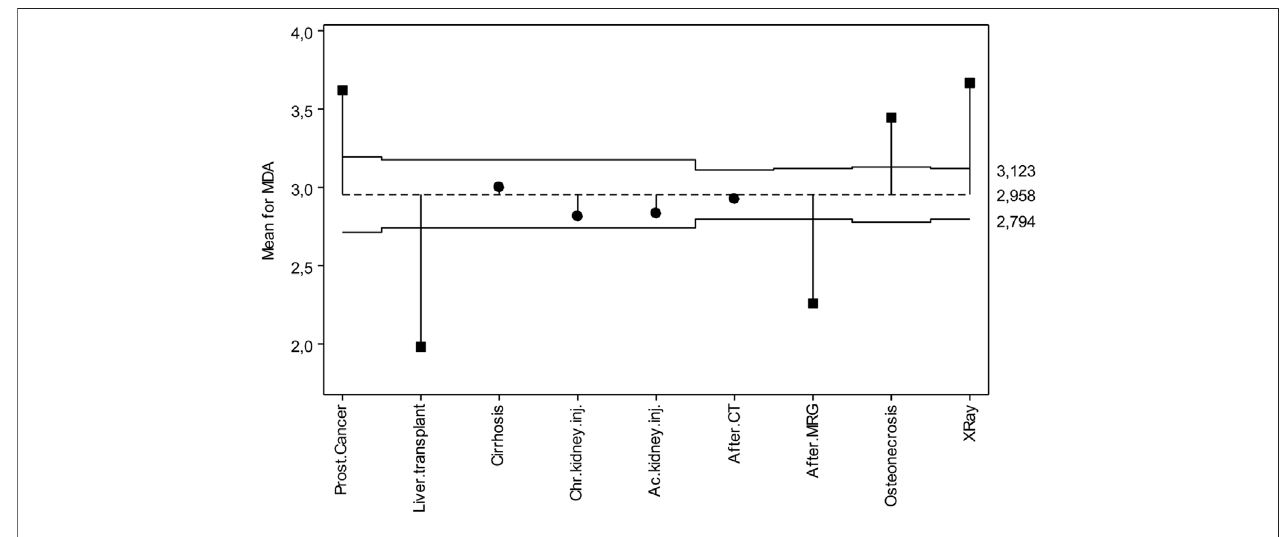
FIGURE 1 | ANOM diagram for MDA levels.